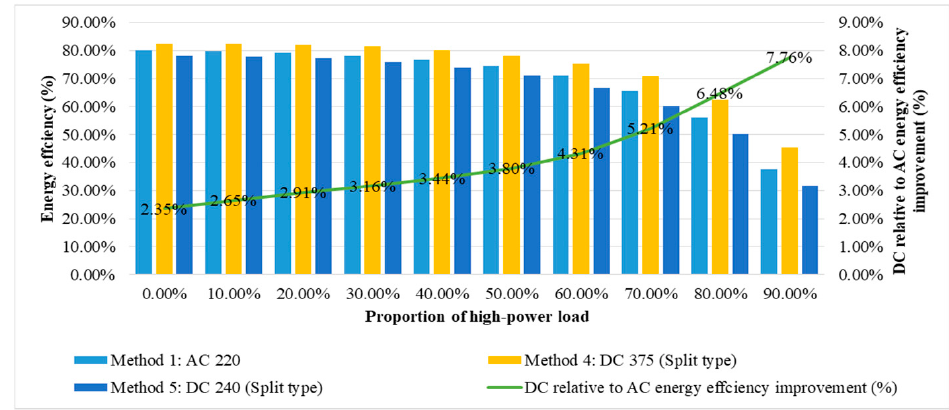
Figure 15. The relationship between the proportion of high-power load and the improvement of DC–AC energy efficiency. DC–AC energy